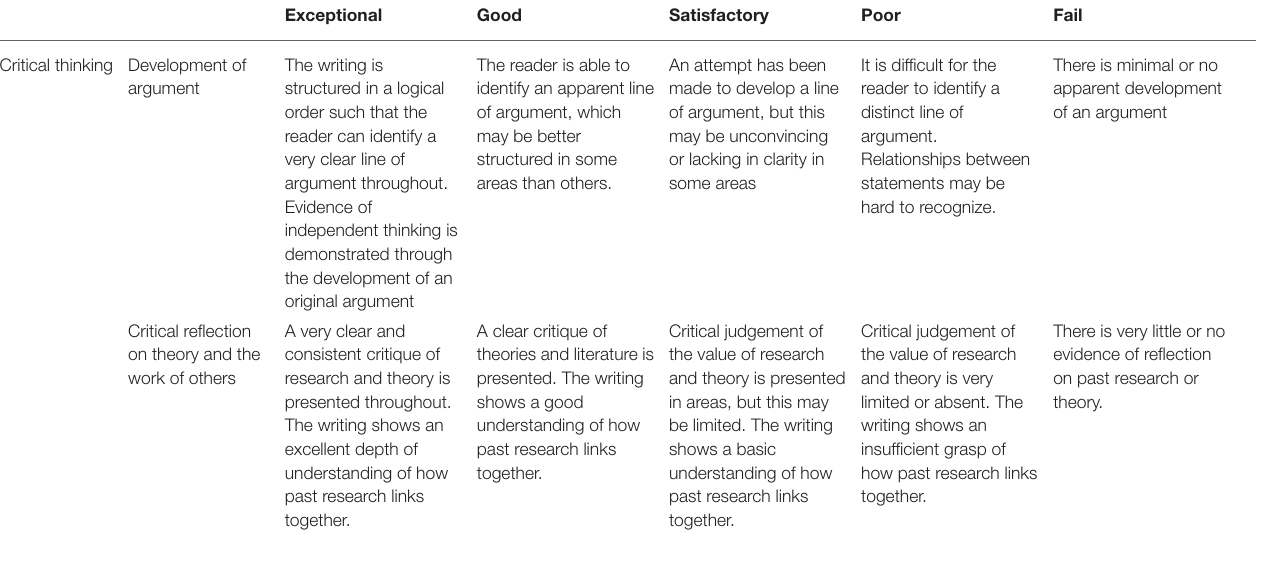
TABLE 3 | Extract of the rubric designed for marking—example of criteria related to the learning outcome of critical thinking in essay questions in